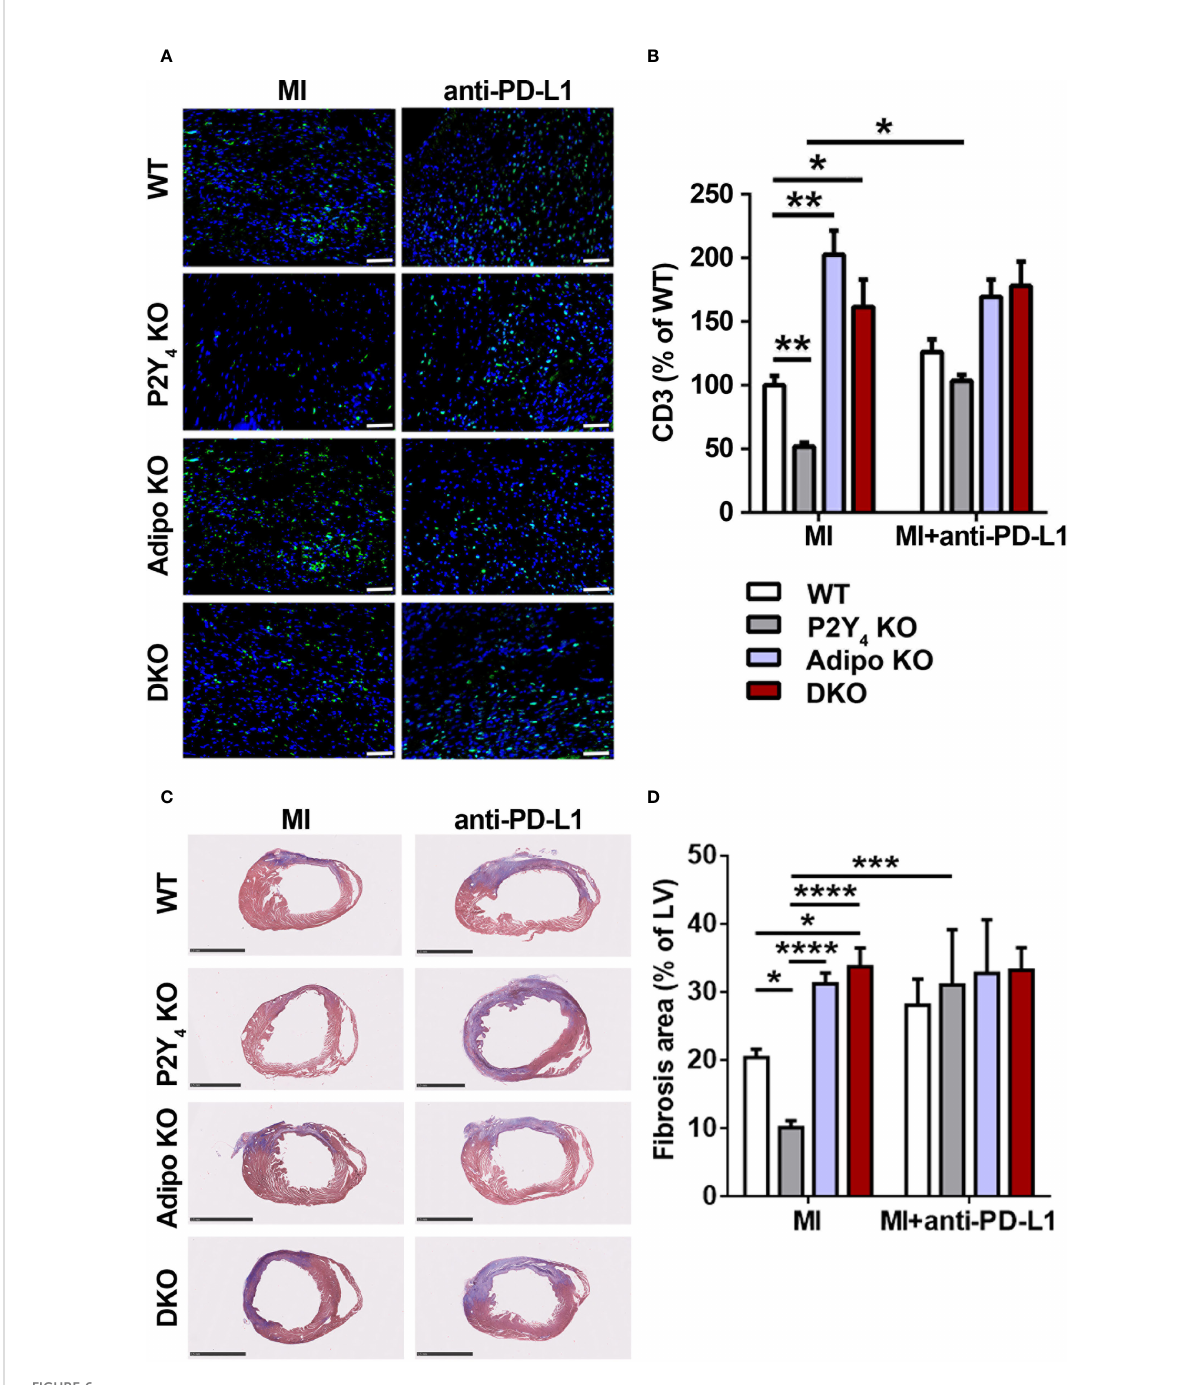
FIGURE 6 Anti-PD-L1 blocking antibody inhibits the reduction of T cell in fi ltration and fi brosis observed in ischemic P2Y 4 KO hearts. (A) Representative T cell staining (CD3) in myocardial infarct sections of WT, P2Y 4 KO, adiponectin KO (Adipo KO) or P2Y 4 /adiponectin double KO (DKO) mice, 7 days after LAD ligation using anti-CD3 (green) and Hoechst in blue (20x magni fi cation) (scale bar = 50 m m). Mice were intraperitoneally injected or not (MI), with anti-PD-L1 blocking antibody (10 µg/g), 1h before LAD ligation then at days 1, 3 and 5 post-LAD ligation. (B) CD3 + cell quanti fi cation in representative counting surface/ fi eld (0.1 mm 2 ) of myocardial infarct sections, 7 days after LAD ligation. Data are expressed as percentages compared to T cell number in WT ischemic mice and obtained using ImageJ software by examining 30 fi elds per heart at 100x magni fi cation (n = 5-6). (C) Representative Masson ’ s trichrome staining of cardiac fi brosis (in blue) in WT, P2Y 4 KO, Adipo KO or DKO mice, 7 days after LAD ligation, injected or not with anti-PDL1 blocking antibody (10 µg/g)) (scale bar = 2.5 mm). (D) Fibrosis area represents collagen staining in blue quanti fi ed by color image analyser ImageJ in left ventricle (LV) and expressed as percentages of total LV surface (2.5x magni fi cation) (n = 5-6). Data represent mean ± SEM. *p < 0.05; **p < 0.01; ***p < 0.001; ****p <